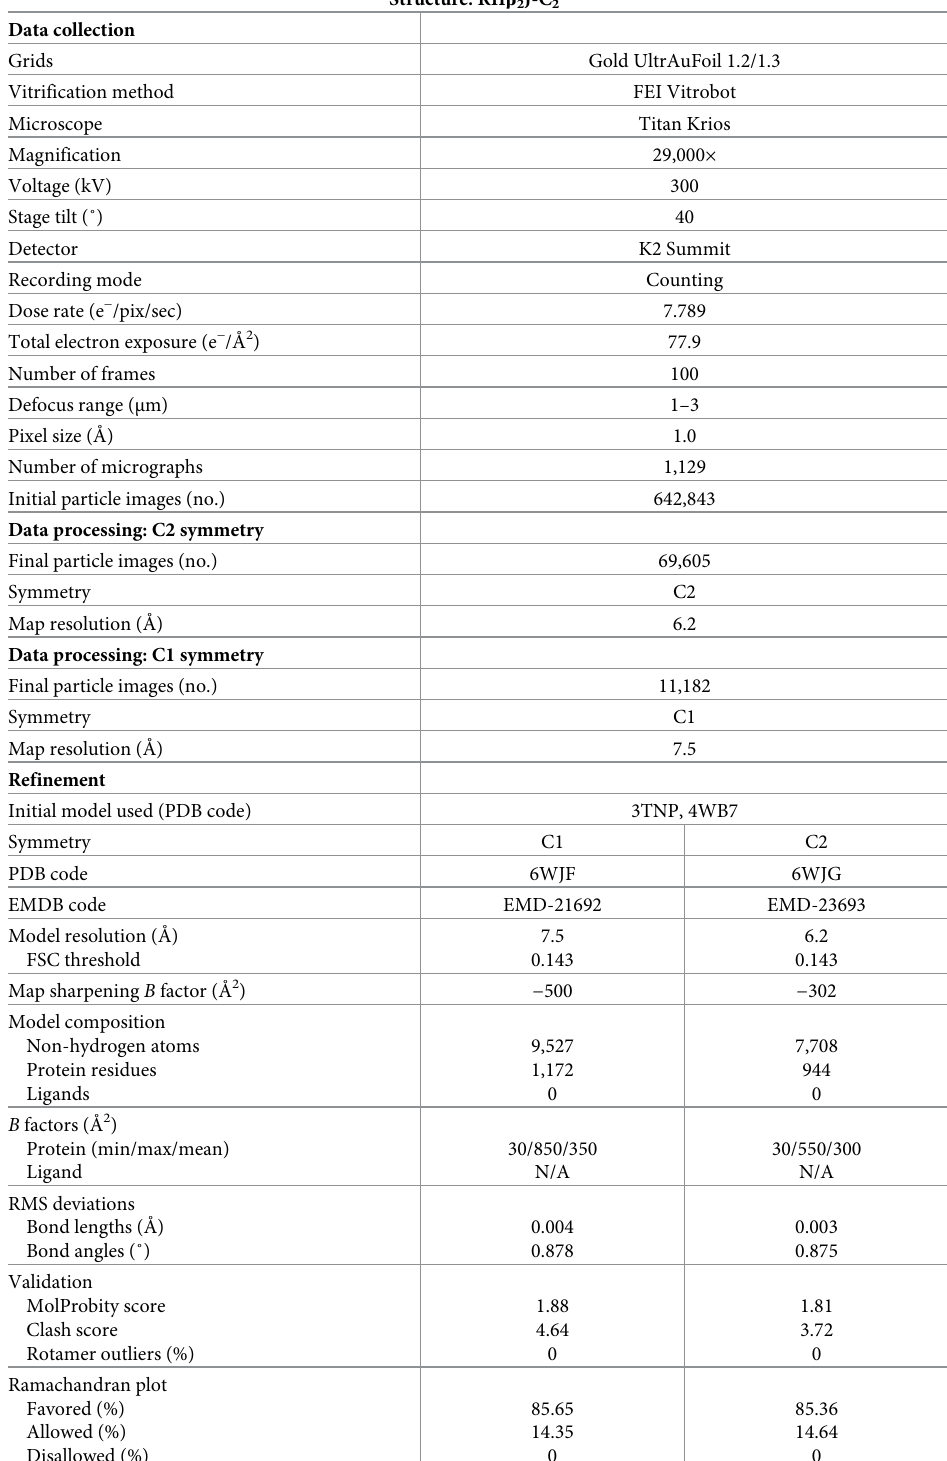
Table 1. Cryo-EM data collection, refinement, and validation